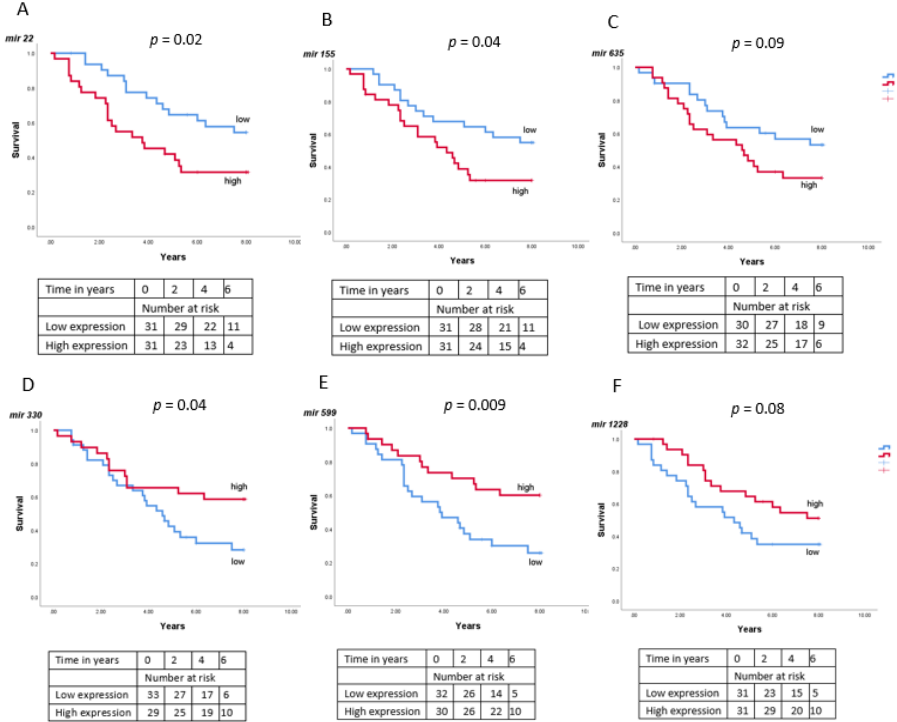
Figure 9. The relation between low and high miRNA expression and survival was determined in a group of 64 Uveal Melanoma patients from Leiden, using Kaplan-Meier survival curves ( A – F ). A log-rank test was used to determine significance. p ≤ 0.05 was considered significant. ( A ) miR-22; ( B ) miR-155; ( C ) miR-635; ( D ) miR-330; ( E ) miR-599; ( F ) miR-1228.